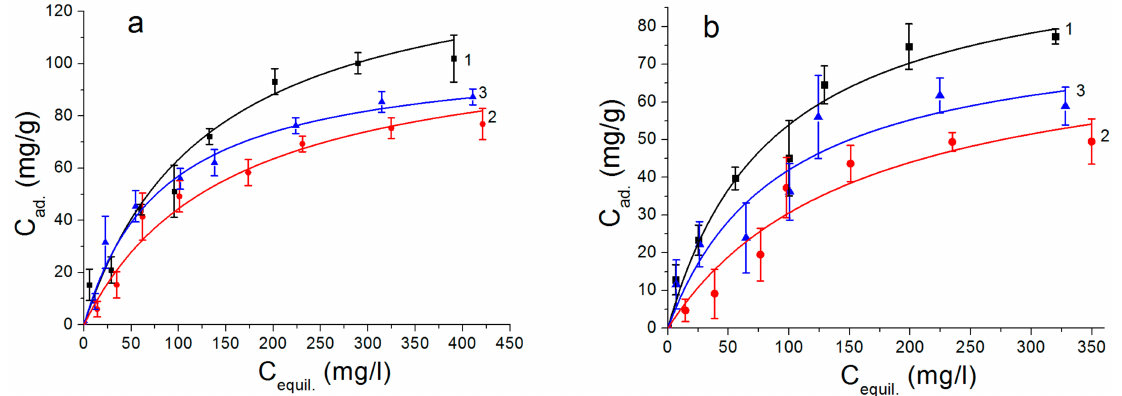
Figure 7. Adsorption isotherms of As(V) ions on the nanostructures with ( a ) and without iron ( b ). 1: Nanosheets; 2: nanoplates; 3: